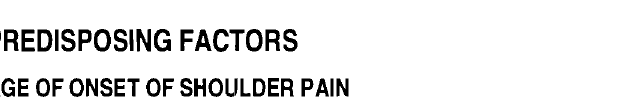
TABLE IV: FACTORS AGGRAVATING SHOULDER